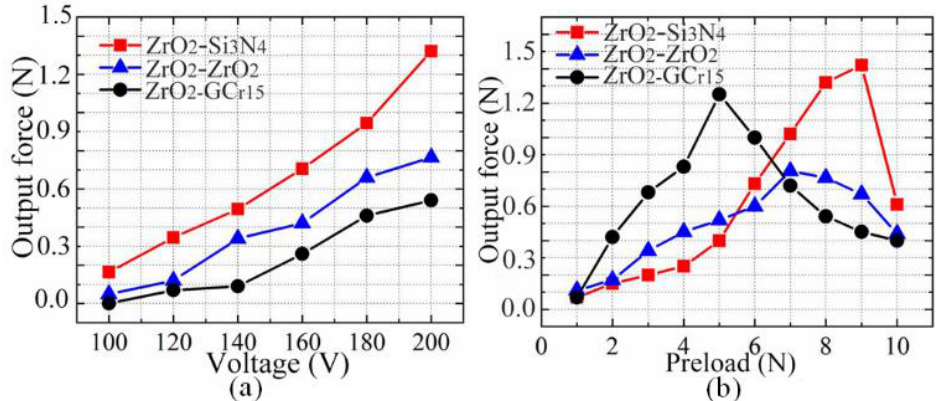
Figure 4. Characteristics of the output force. ( a ) Relationship between the output force and excitation voltage. ( b ) Relationship between the output force and preload.